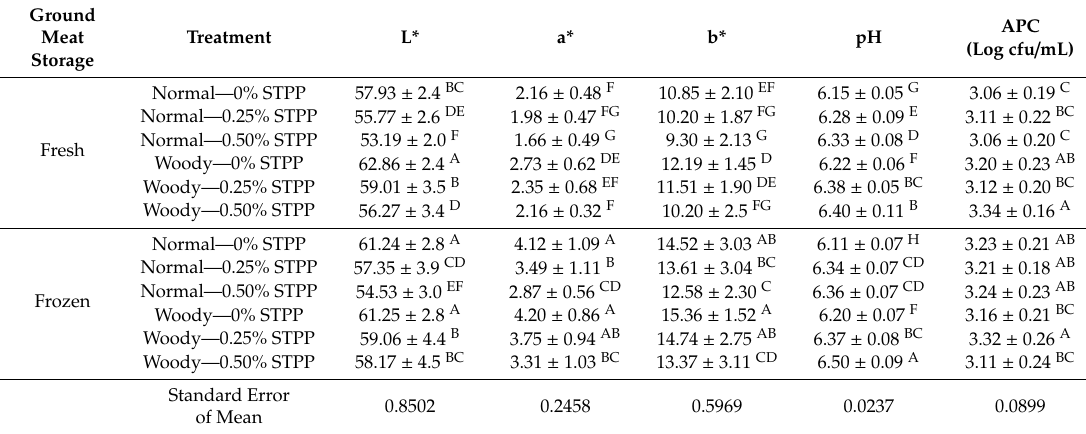
Table 1. Color (CIE L*a*b*), pH, and aerobic plate count (APC) data for fresh vs. frozen ground chicken breast (normal and woody) treated with di ff erent levels of sodium tripolyphosphate (STPP; lsmean ± SD) 1